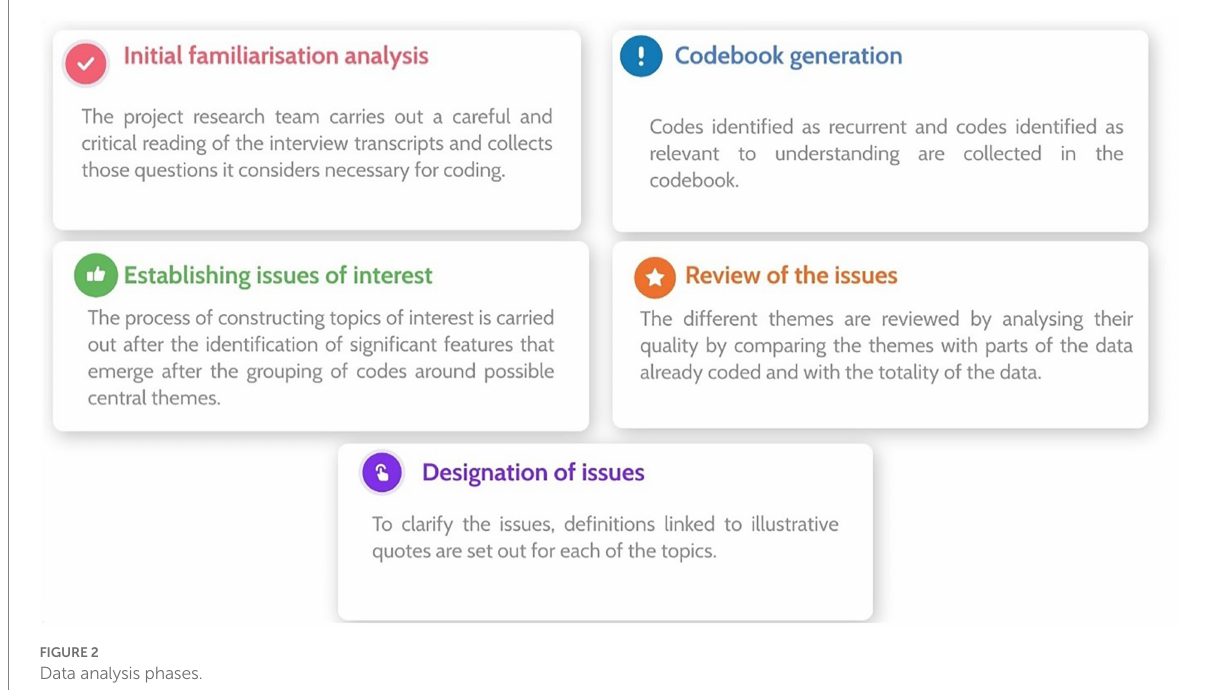
FIGURE 2 Data analysis